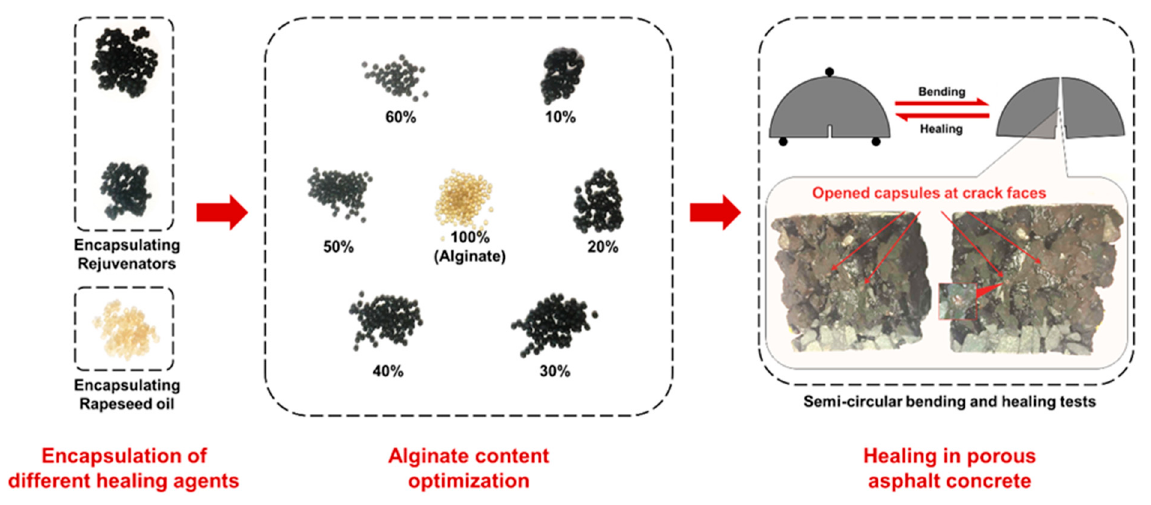
Figure 2. Development of the calcium alginate capsules healing system.